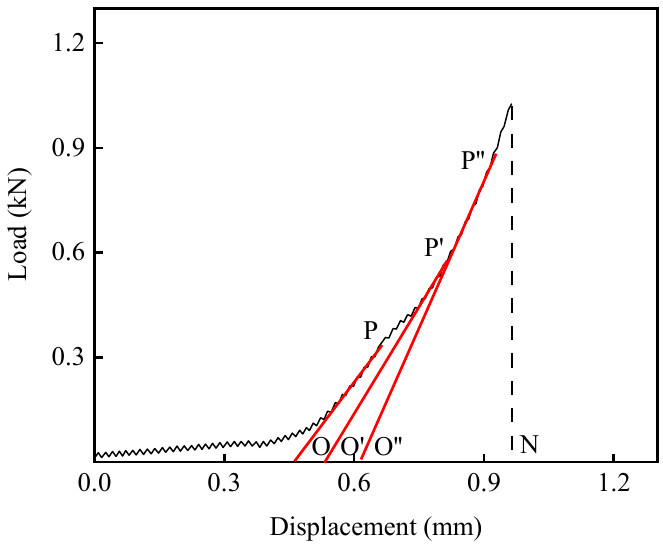
Figure 10. Load displacement curve of mixture.